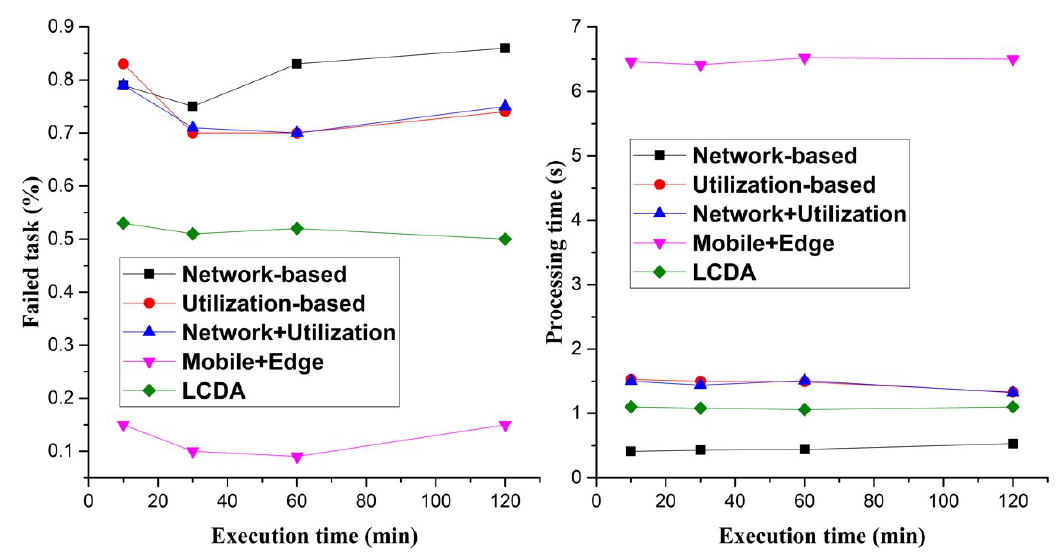
Figure 7. Performance comparison with respect to execution time.